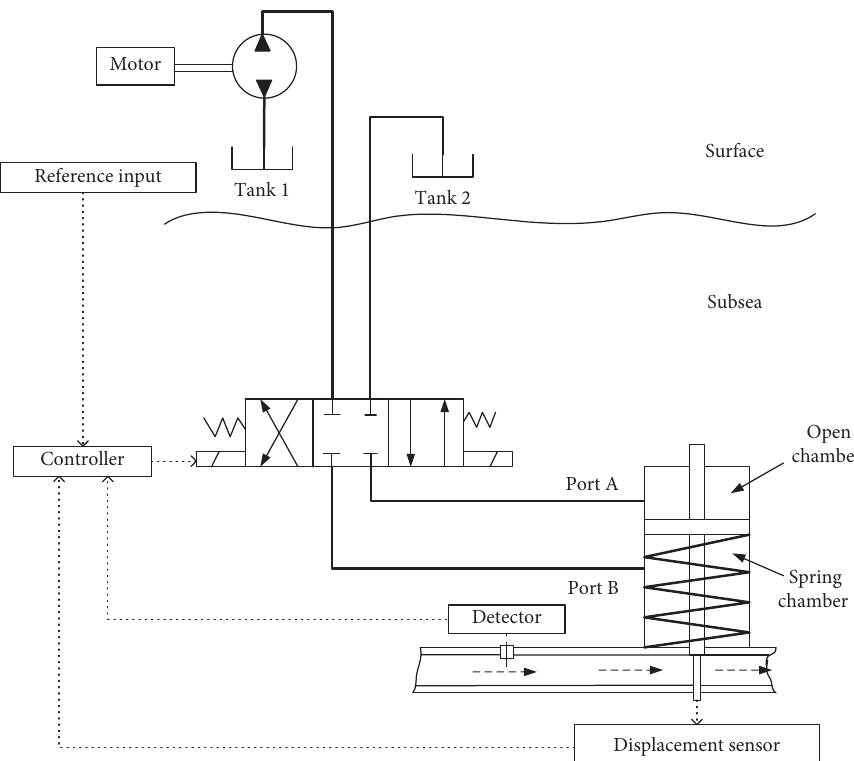
Figure 1: Underwater electrohydraulic composite valve position control system.